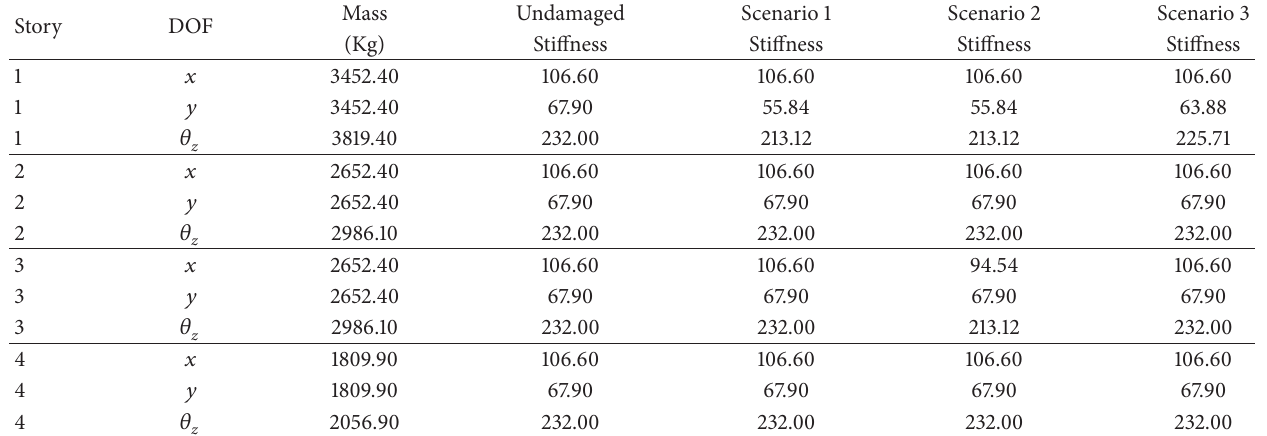
Table 7: Mass and horizontal story stiffness (MN/m) of undamaged and damaged 12-DOF model. Story